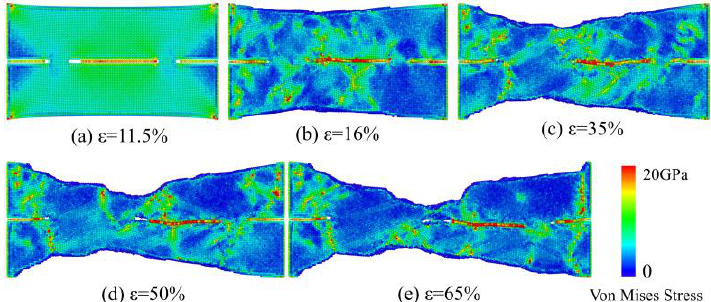
Figure 17. Crystal structure and dislocation line distribution of Gr/Cu-2 under different strains. ( a ) ε = 11.5%, ( b ) ε = 16%, ( c ) ε = 35%, ( d ) ε = 50% and ( e ) ε = 65%.